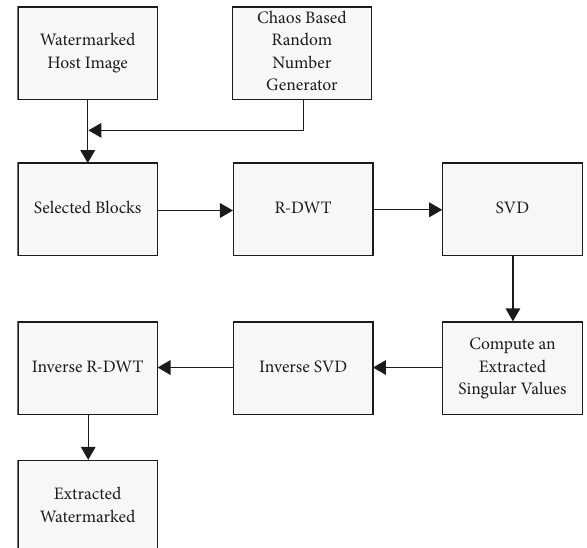
Figure 10: Proposed watermarking extraction